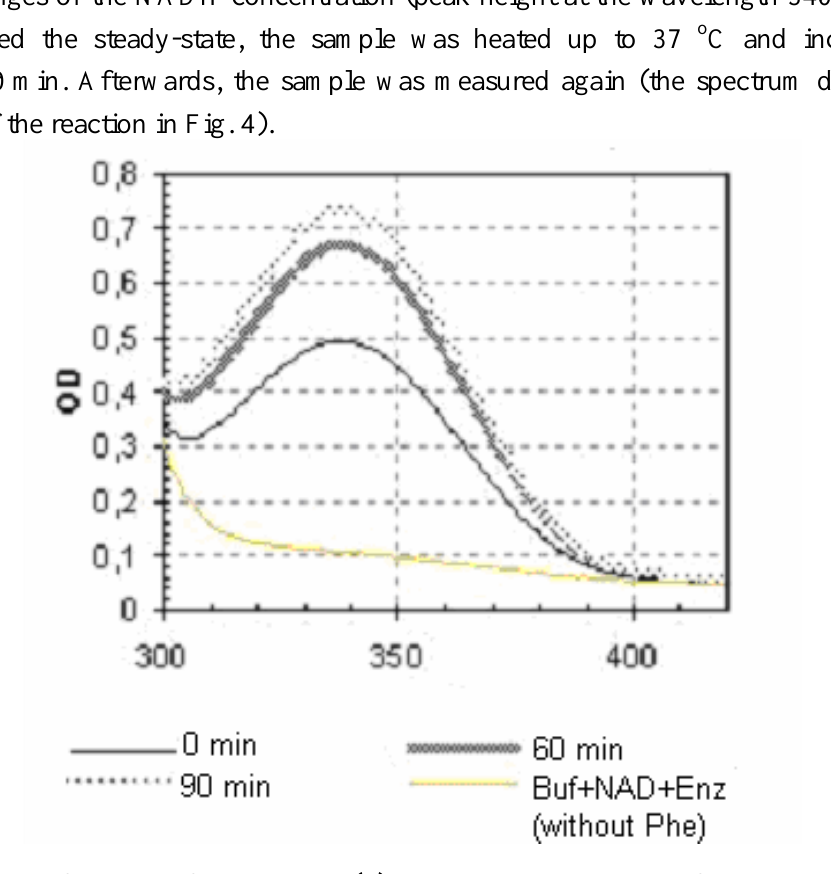
PO buffer solution 2 4